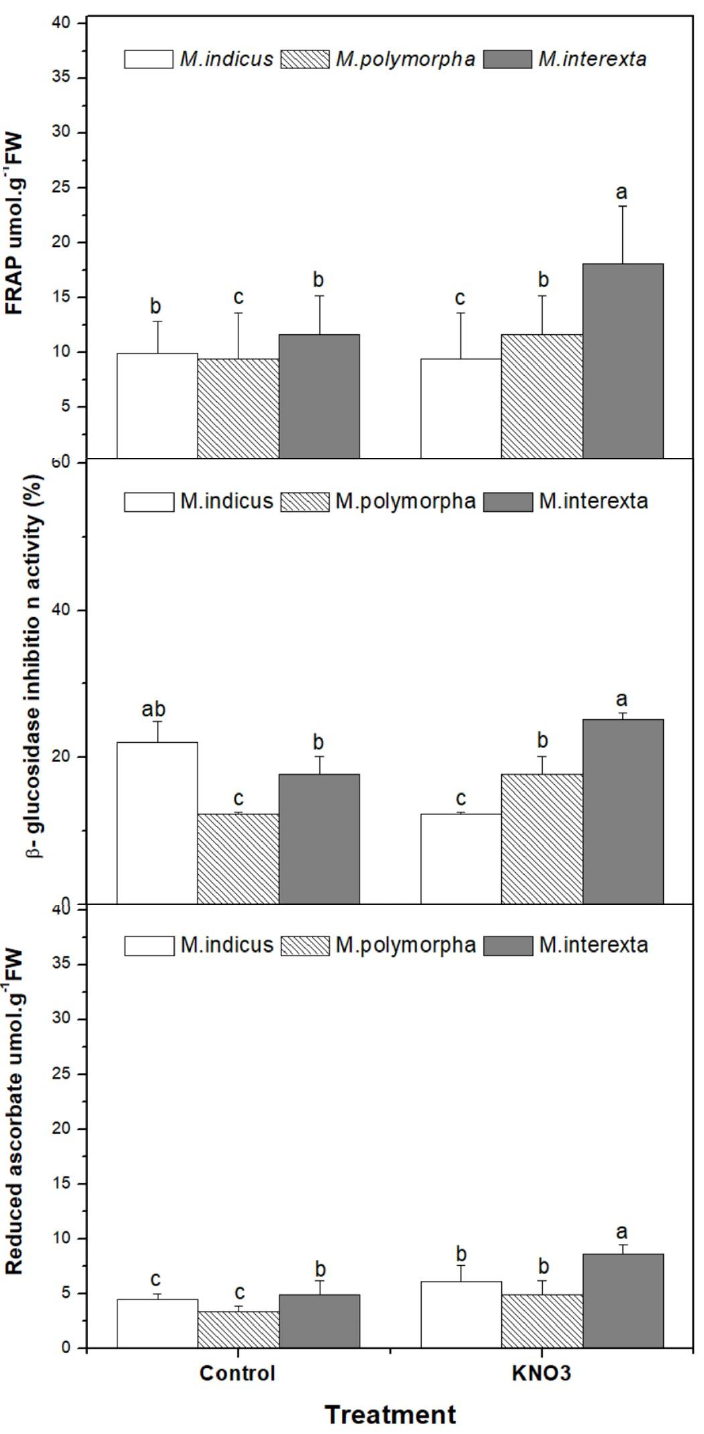
Figure 3. Effect of KNO 3 priming on antioxidant activity of three species of Medicago sprouts. Values are represented by mean ± standard deviation of at least three independent replicates. Within the same species, different letters on the bars indicate significant differences at p <